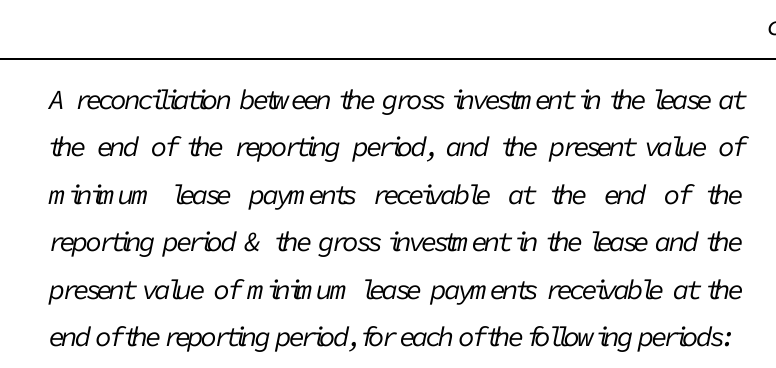
Table showing the results of checklist as per paragraph 47 LKAS 17